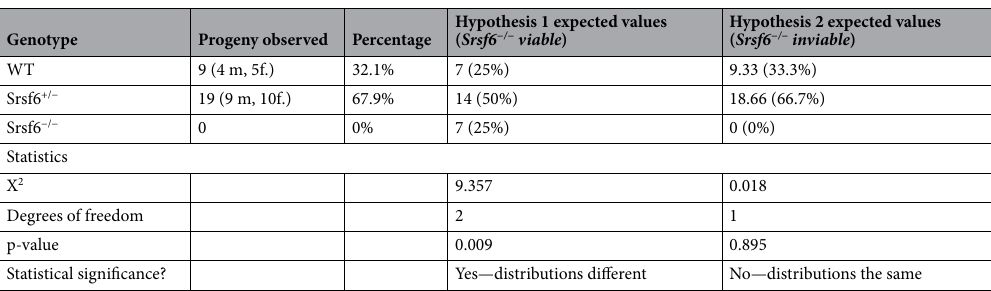
Table 1. Genotypes of the progeny from the Srsf6 +/ − intercross.